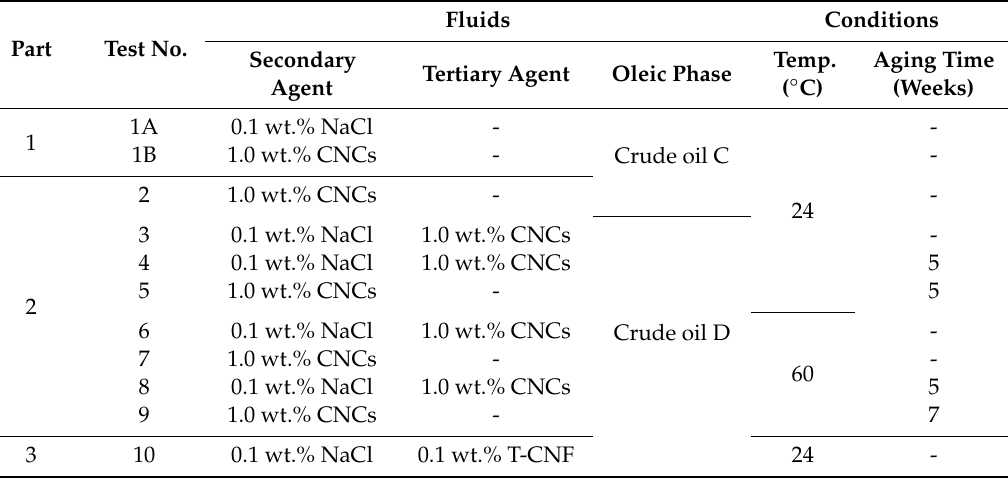
Table 5. Overview of the di ff erent tests conducted. The letters A and B denote that the experiments were conducted on the same core plug. The test number corresponds to the core number in Table 1. Fluids Conditions Part Test No. Temp. Aging Time Secondary Tertiary Agent Oleic Phase ( ◦ C) (Weeks) Agent 1A 0.1 wt.% NaCl - - 1 1B 1.0 wt.% CNCs - - Crude oil C 2 1.0 wt.% CNCs - - 24 3 0.1 wt.% NaCl 1.0 wt.% CNCs - 4 0.1 wt.% NaCl 1.0 wt.% CNCs 5 5 1.0 wt.% CNCs - 5 2 6 0.1 wt.% NaCl 1.0 wt.% CNCs - Crude oil D 7 1.0 wt.% CNCs - - 60 8 0.1 wt.% NaCl 1.0 wt.% CNCs 5 9 1.0 wt.% CNCs - 7 3 10 0.1 wt.% NaCl 0.1 wt.% T-CNF 24